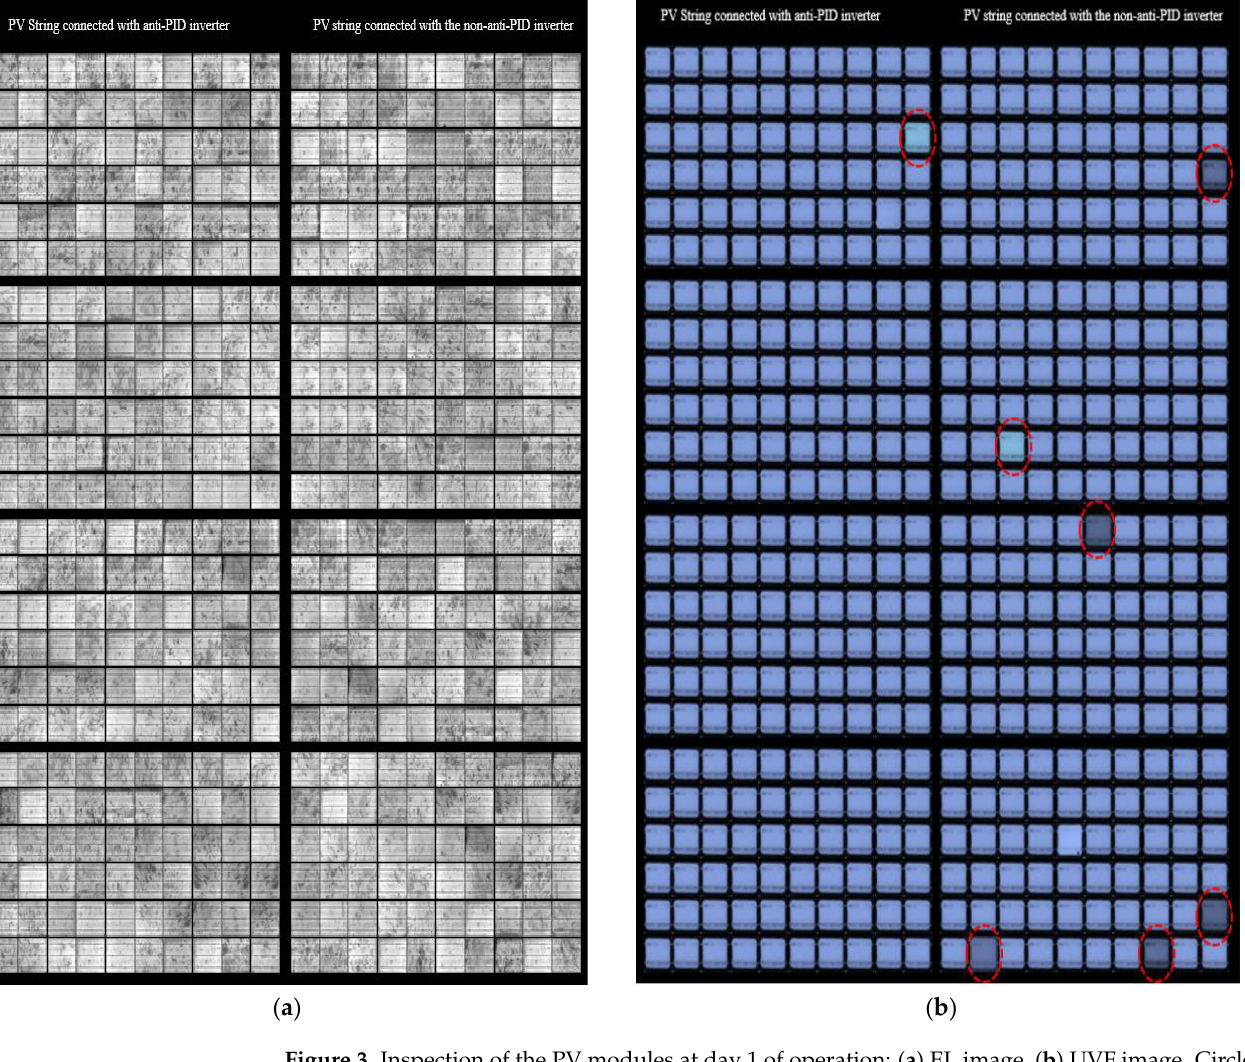
Figure 3. Inspection of the PV modules at day 1 of operation: ( a ) EL image, ( b ) UVF image. Circled cells in the UVF image indicate samples of solar cells with darker cells indicating early-stage